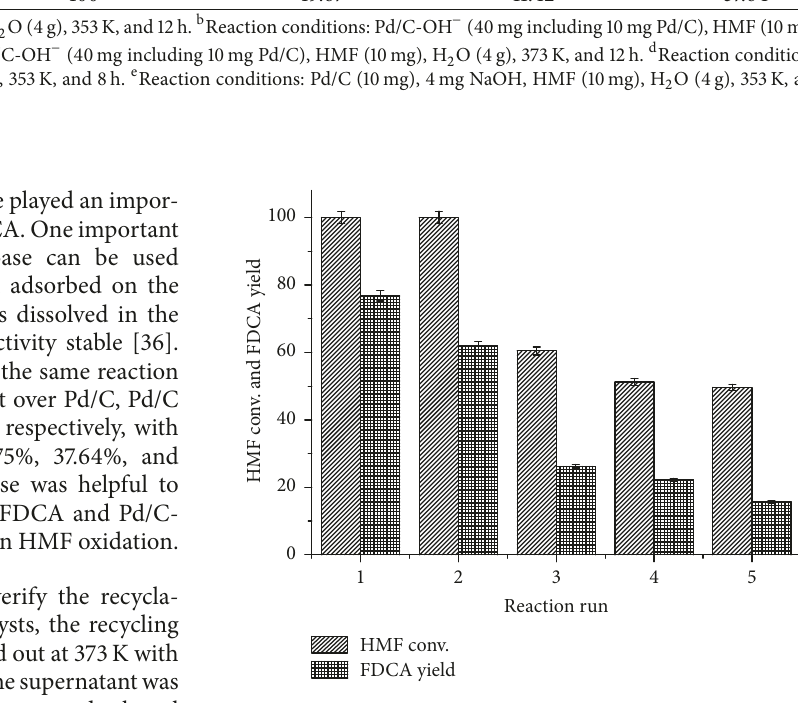
Figure 8: Recycle experiments of the catalyst. Reaction